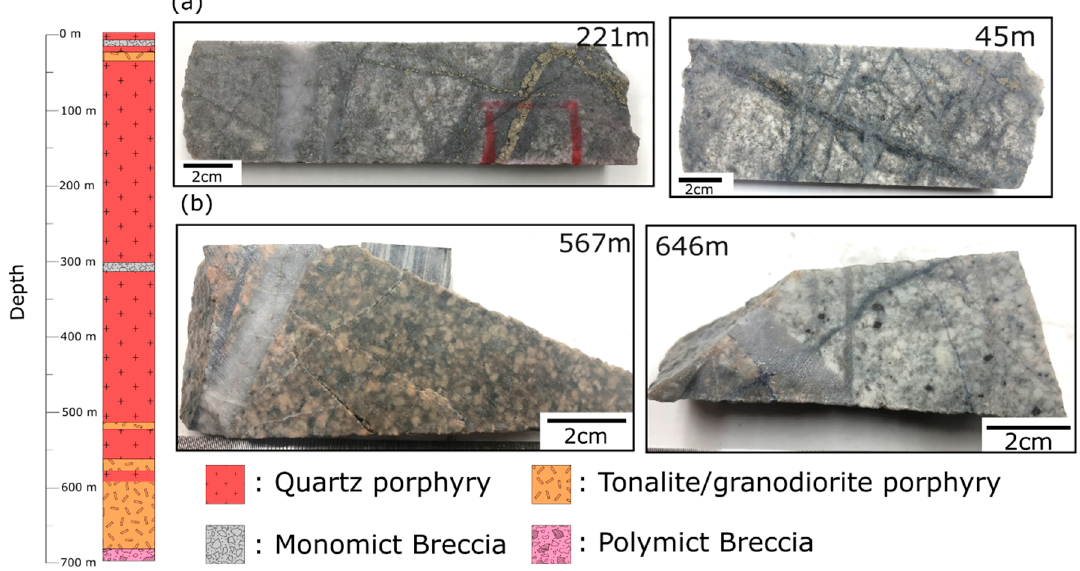
Figure 2. Simplified core log and representative hand specimens, with sampling depths shown. ( a ) Quartz porphyry. ( b ) Tonalite/granodiorite porphyry.